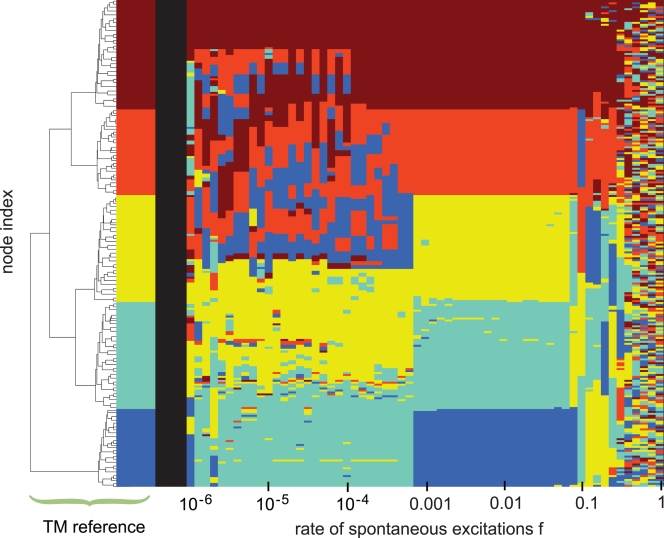
Dynamically detected cluster (DDC vectors) for 10−6<f<1 (right) re-sorted and colored according to the TM reference (left), as described in Figure 2.The region of the image displaying the highest consistency between the TM reference and the DDC vectors (10−3<f<0.1) marks the range, where the dynamics is able to exploit the given topological modules rather precisely. In this range of f the distribution patterns of excitations are dominated by burst regimes (as discussed in [36]. The pattern formation for f>0.1 is strongly influenced by random firing events, while for f<10−3 the modular boundaries are followed only partly by the dynamics, hinting at another form of correlation between dynamics and topology, which acts on a larger topological scale.